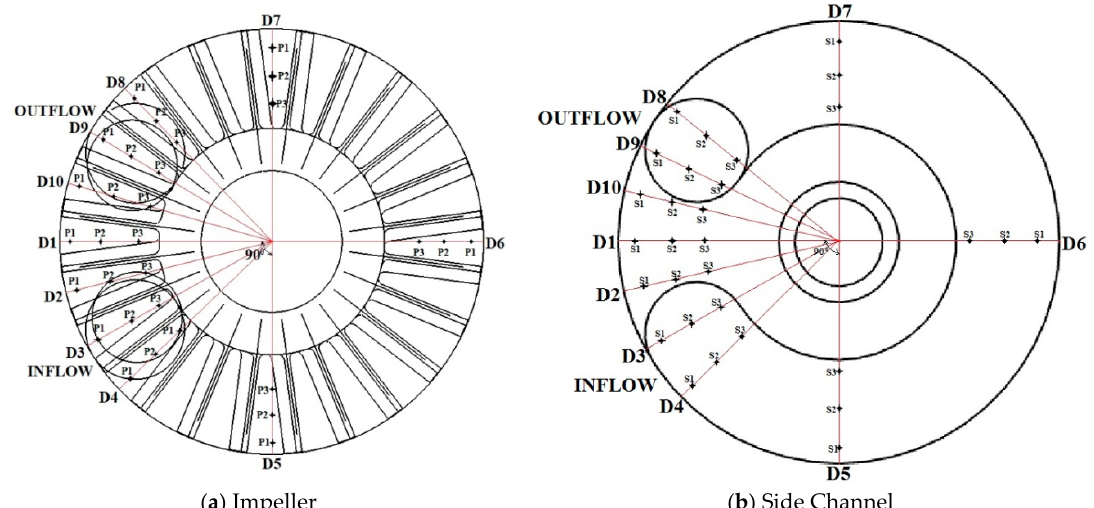
Figure 4. Monitoring points for three pump cases.